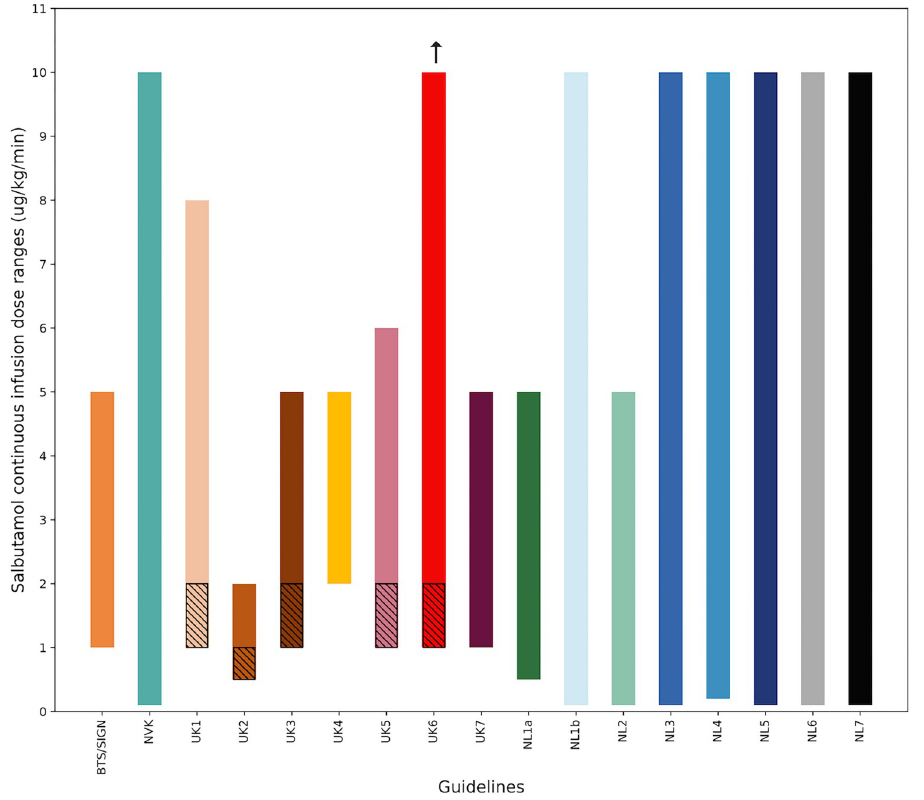
Fig 2. Recommended dose ranges for continuous salbutamol infusions across sampled CPGs from the UK and the Netherlands. Hatching indicates starting dose ranges. The arrow indicates the absence of a maximum dose recommended by the concerned guideline. UK2 and UK5: maximum doses calculated for a child of 10 kilograms based on the absolute maximum dosages recommended by each CPG.